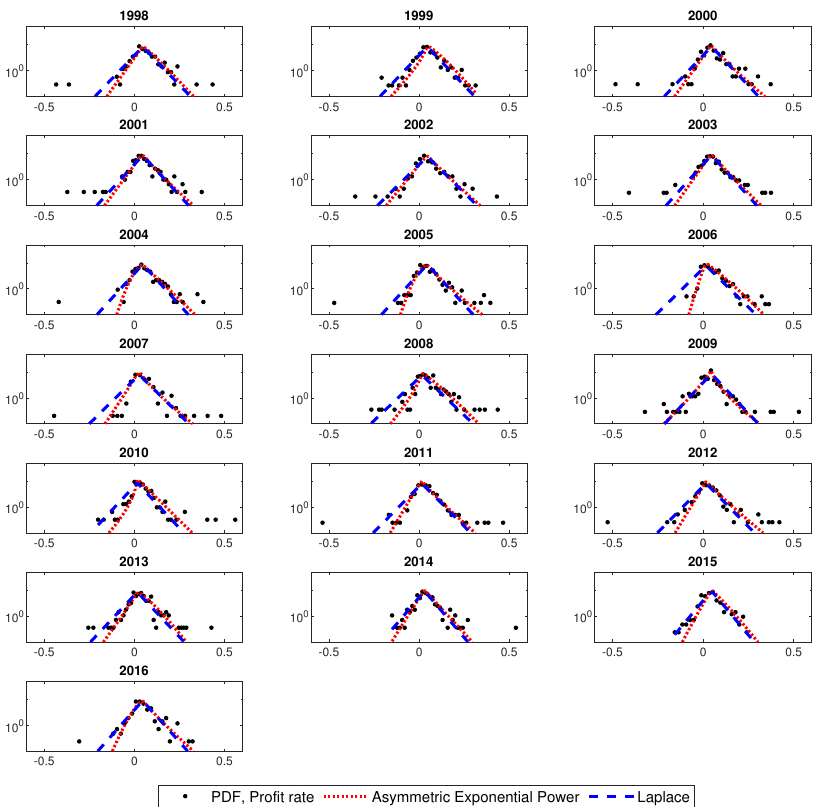
Figure 3. Probability Density Function (PDF) of profit rates along with the AEP (dotted line) and Laplace (dashed line) distribution. The results refer to the 200 largest long-lived firms according to their sales in 2016.